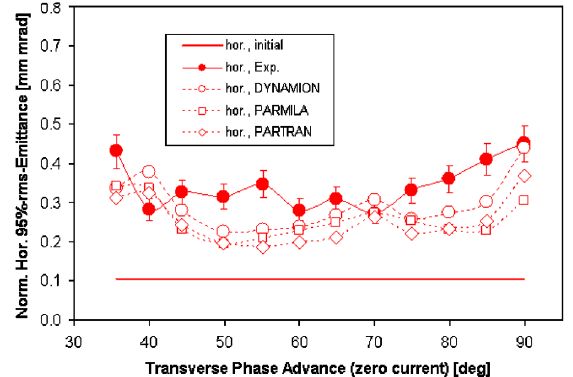
FIG. 15. (Color) Transverse normalized 100% rms emittances along the beam line as simulated by the three codes for a transverse zero current phase advance (cid:4) o of 60 (cid:1) .